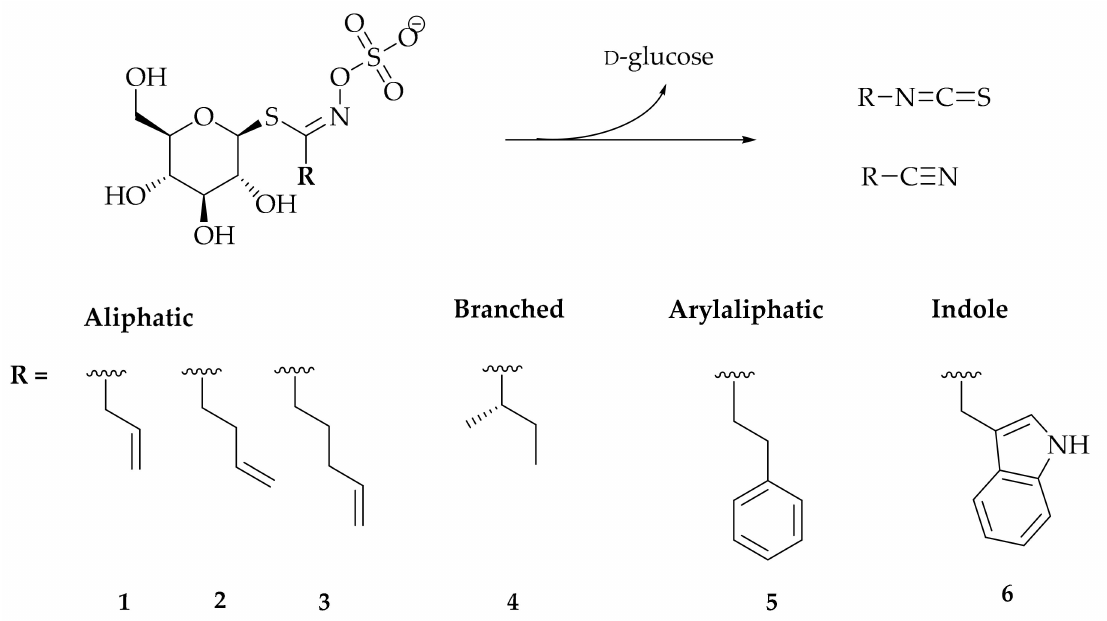
Figure 1. General scheme of glucosinolate degradation with the structures identified in